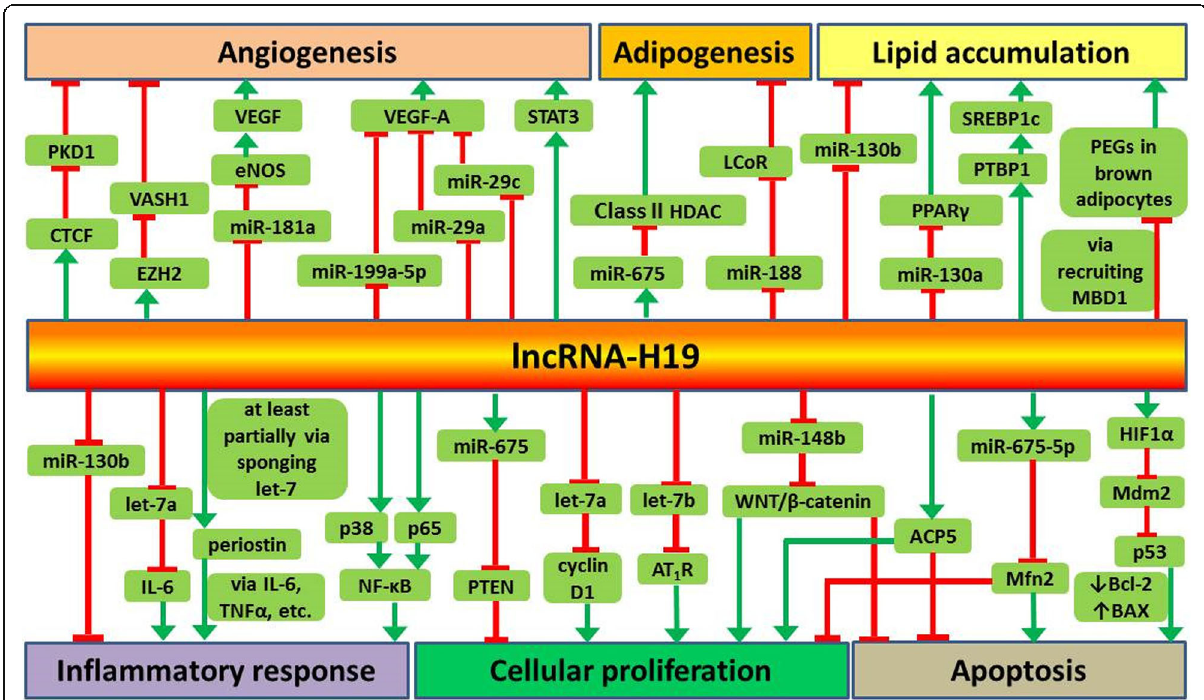
Fig. 1 The role of lncRNA-H19 and its targets in atherosclerosis-related metabolisms. LncRNA-H19 may regulate several targets implicated in the dysregulation of angiogenesis, adipogenesis, lipid accumulation, inflammatory responses, cellular proliferation and apoptosis.